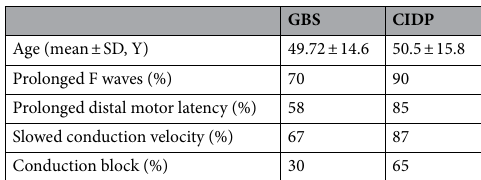
Table 2. Demographic and clinical data of patients.